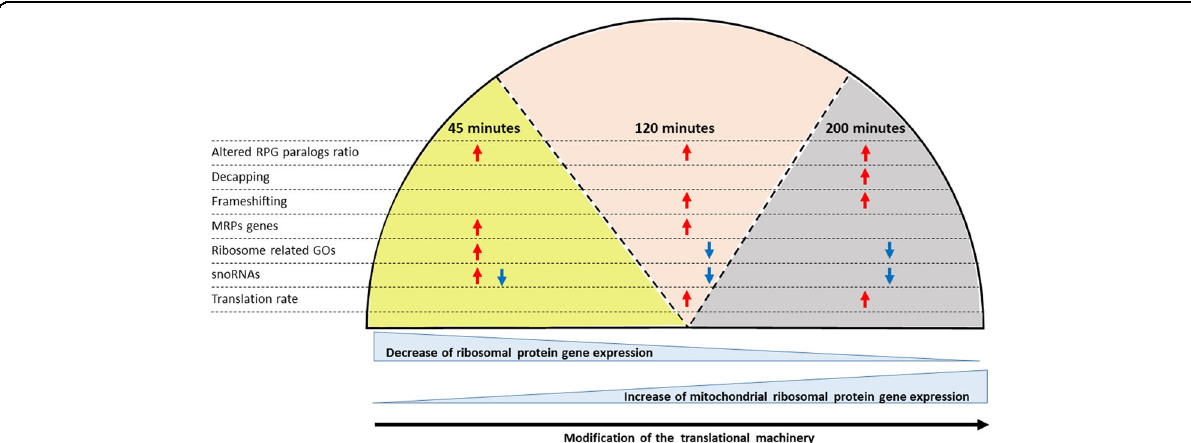
Fig. 3 Summary of intracellular changes in protein synthesis machinery induced by acetic acid treatments. Changes after exposure of 45 (light yellow background), of 120 (pink background), and of 200 (gray background) min determine: differential expression of the cytosolic ribosomal protein couples of ohnologs, altering their relative content in the ribosomes (altered ribosomal protein genes (RPGs) ohnologs ratio); differential expression of snoRNAs and of mitochondrial ribosomal protein genes (MRPGs); upregulation of EDC1, encoding an mRNA decapping protein, the downregulation of ASC1, affecting translation rate and frameshifting; enrichment of ribosomal and translation related gene ontologies (GOs). These phenomena are also associated to a general decrease of cytosolic RPGs expression and to the increase of the mitochondrial RPGs